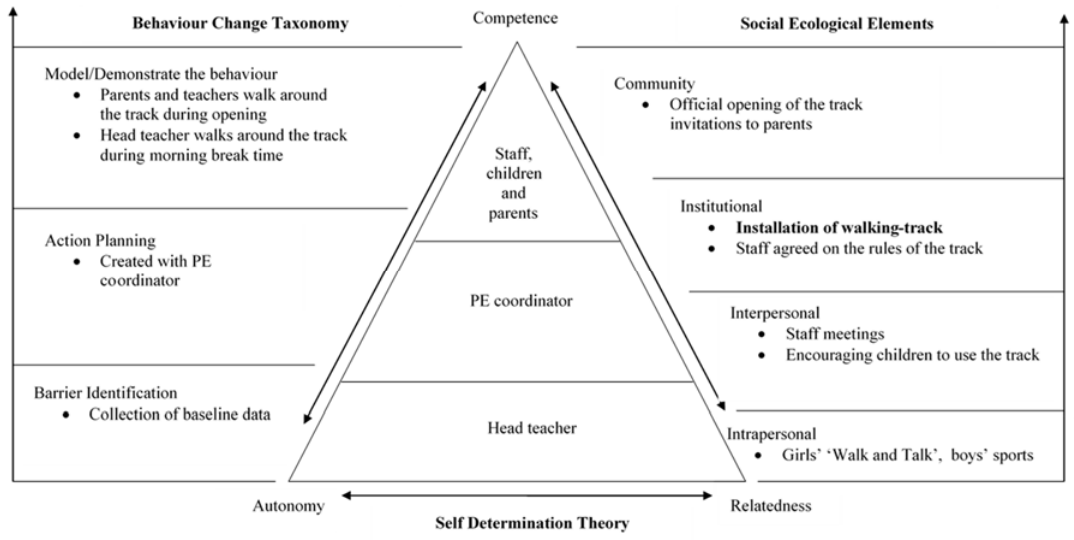
Figure 1. Walking-track intervention model.